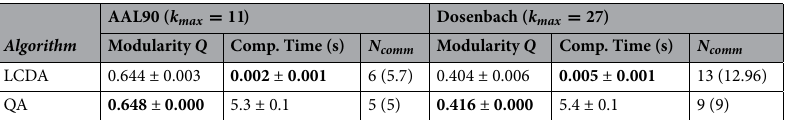
Table 2. Results of community detection on the benchmark brain atlases. Modularity and computational time required for the algorithms to finish [MEAN ± STD]. The number of communities, together with its mean in brackets. All results are averages of 100 different runs. The numbers in bold indicate a better performance. The STD of the QA modularity was 7.85e−17 (AAL90) and 8.54e−05 (Dosenbach).